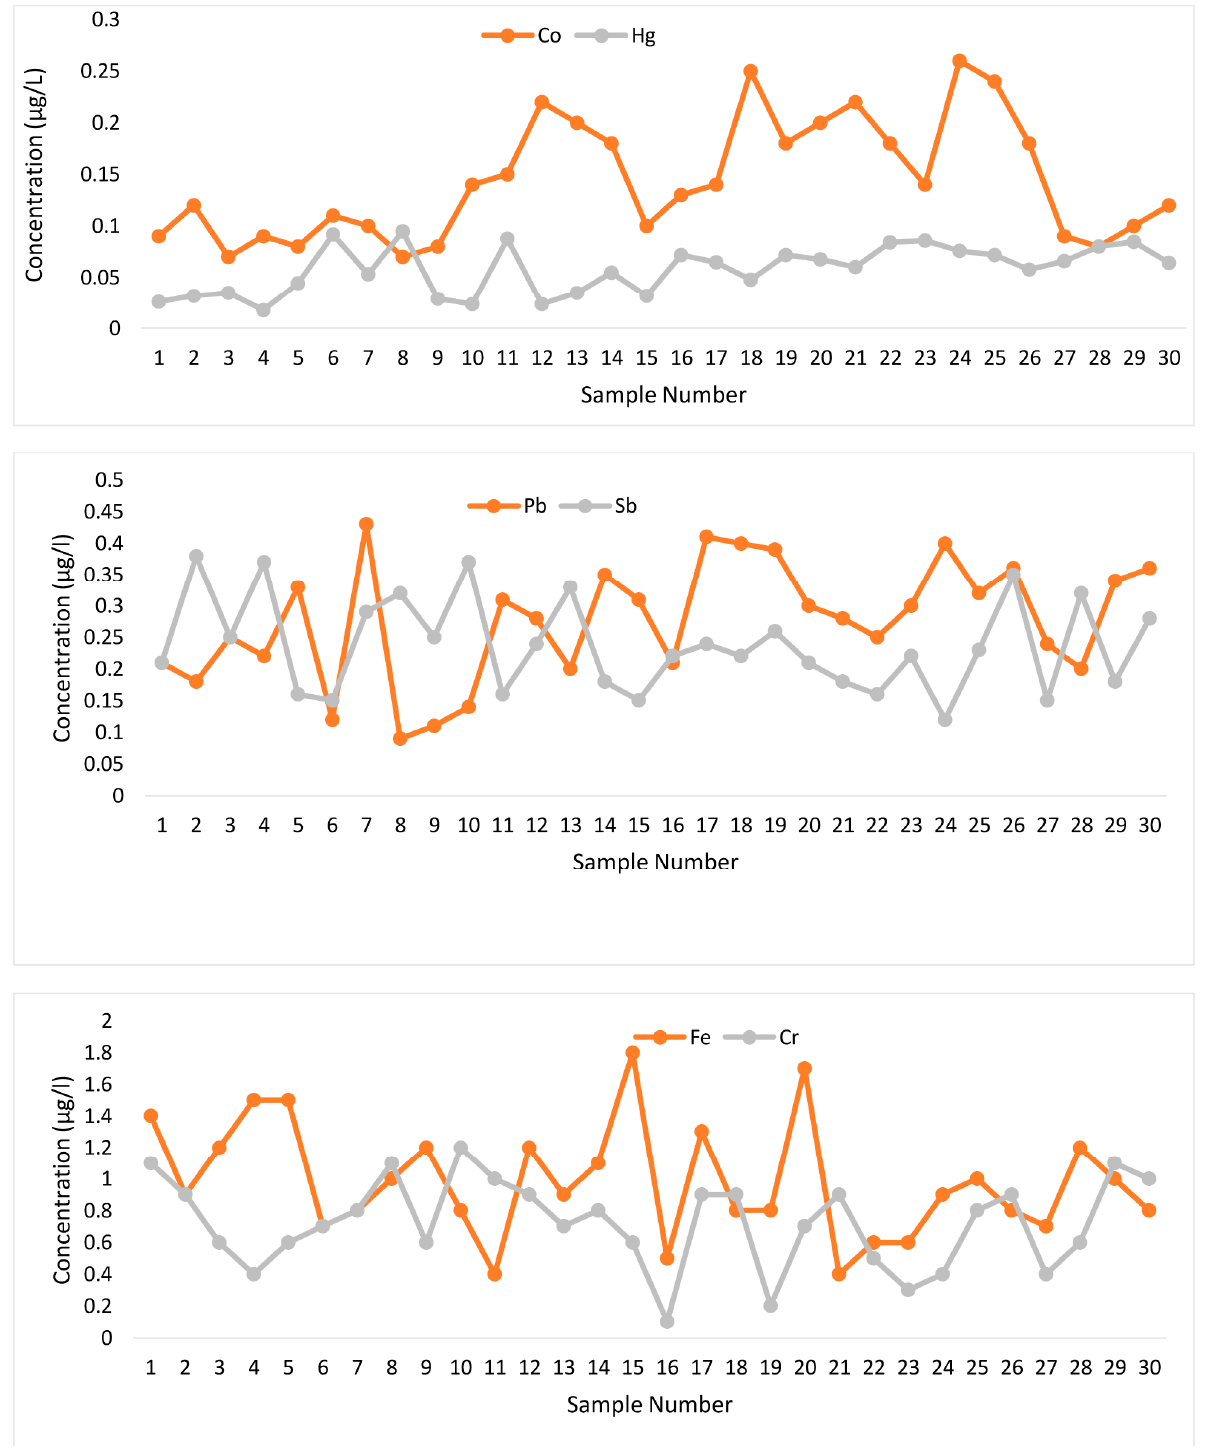
Figure 3. Distribution of Co, Hg, Pb, Sb, Fe, and Cr in seawater samples.